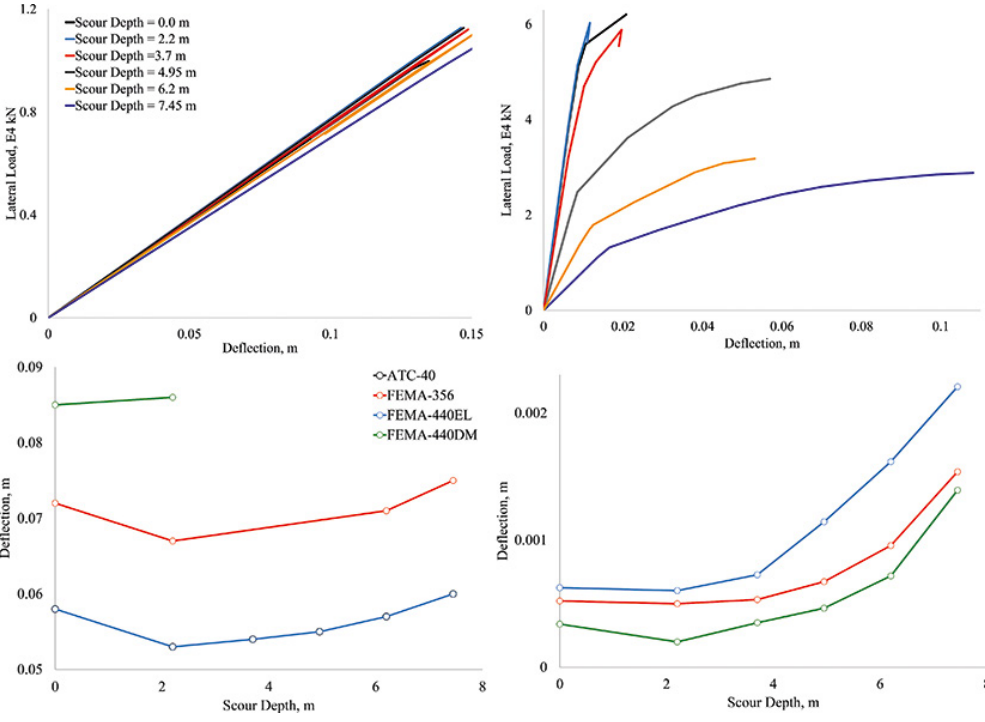
a) longitudinal Figure 6. Pushover curves and performance points for scouring depths